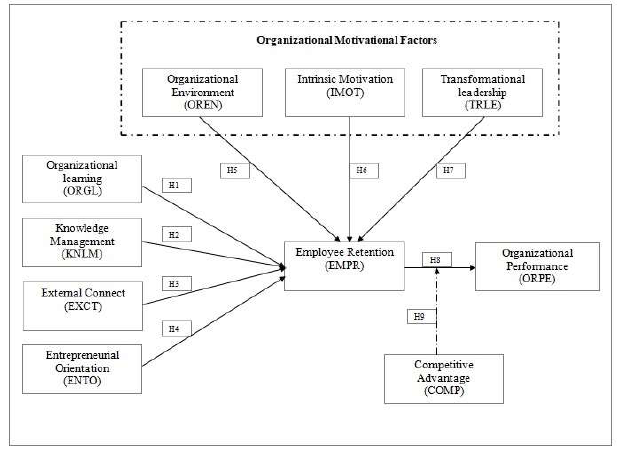
Fig. 1. The proposed research